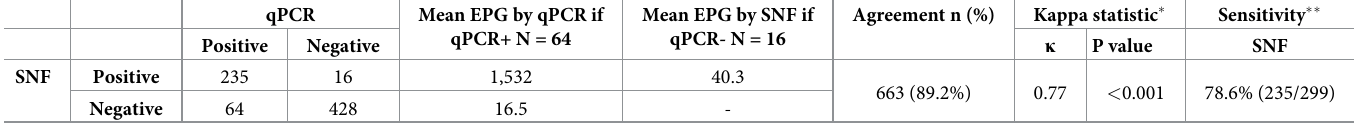
Table 2. Diagnostic agreement between qPCR and SNF, and sensitivity of SNF versus qPCR for diagnosing hookworm